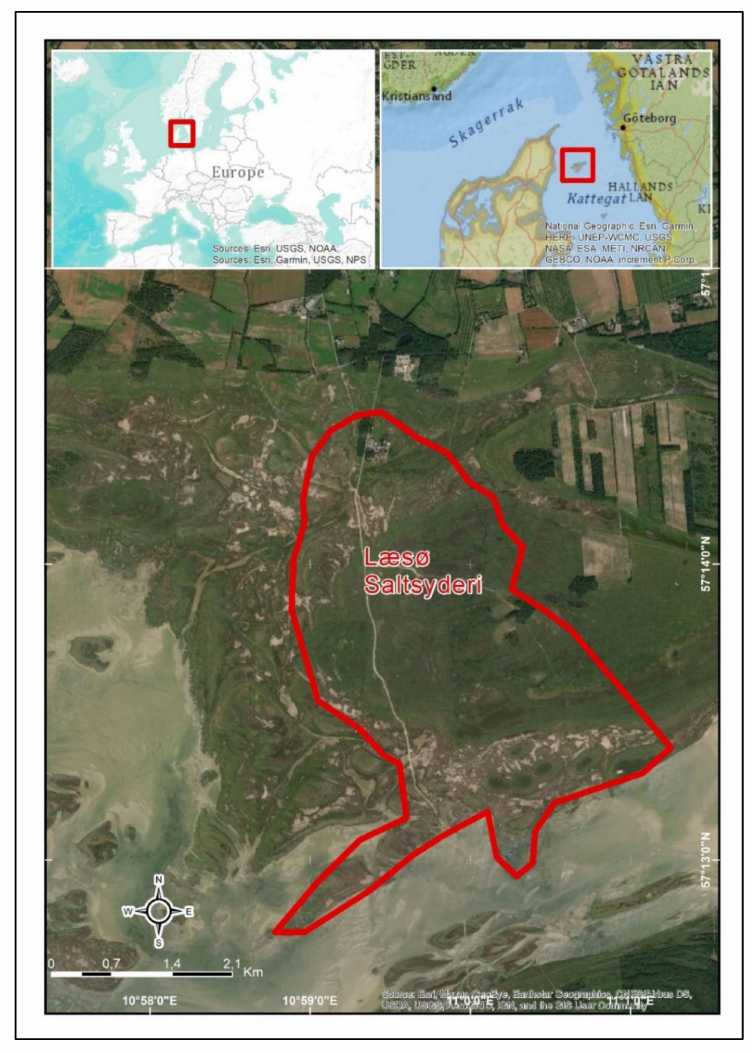
Figure 5. Maps of the study area and location of the Læsø saltworks (Denmark). The perimeter of the salina is delimited in red. Source: Own